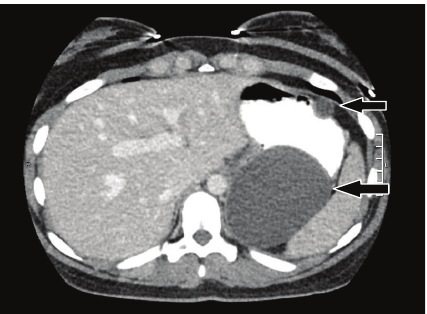
Figure 3: Histological H&E stain. Cystic lesion from greater curvature of stomach showing benign developmental cyst with smooth muscle wall and lined by respiratory ciliated epithelium. 40x magnification.